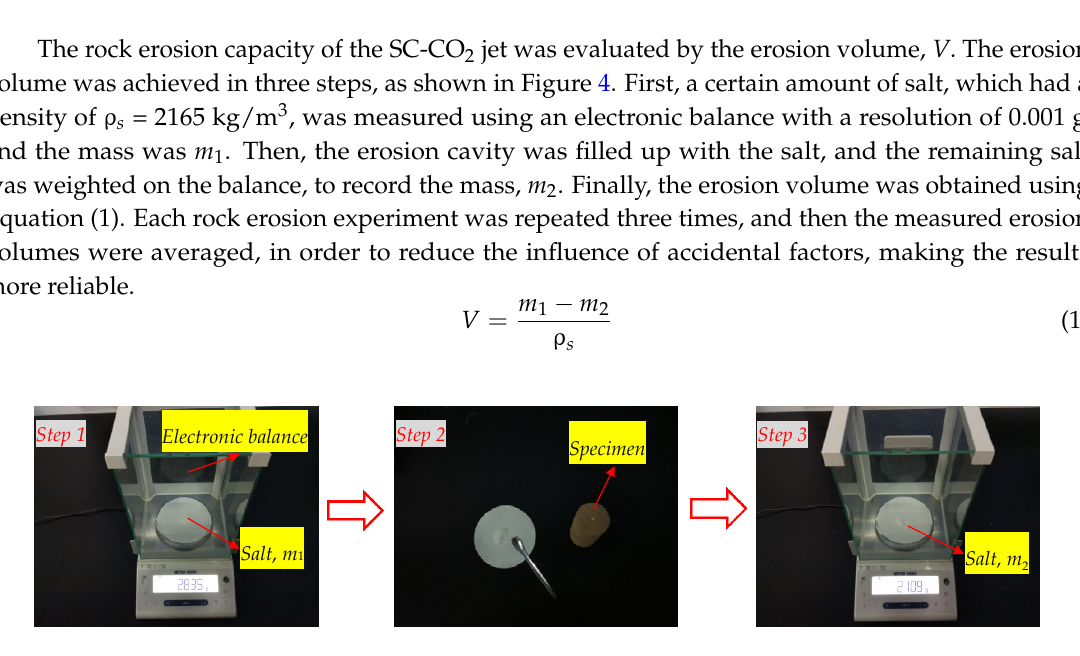
Figure 4. Schematic diagram of the measurement of the erosion volume.